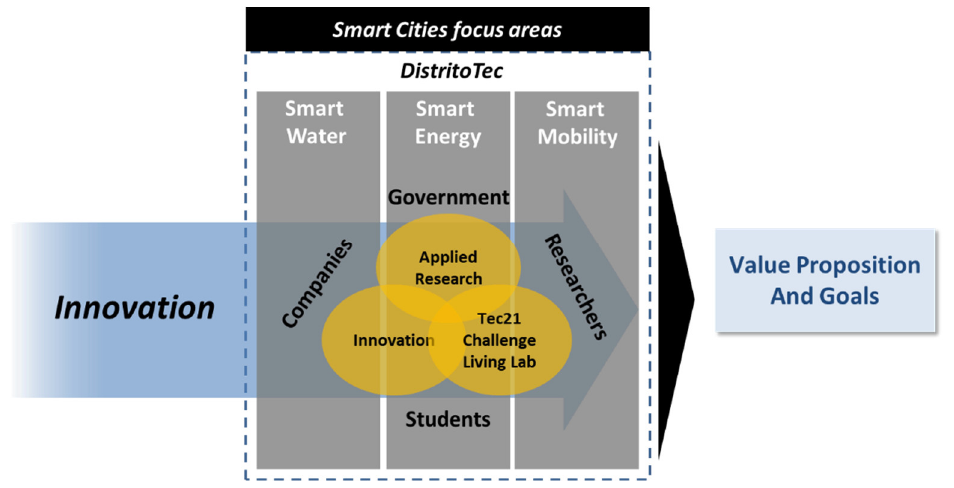
Figure 2. Campus City initiative general innovation model.